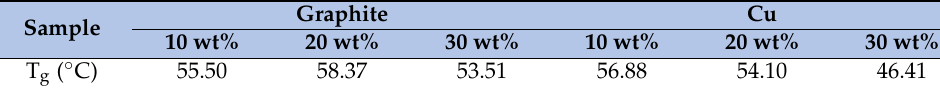
Table 3. Glass transition temperatures for the amount and type of fillers.